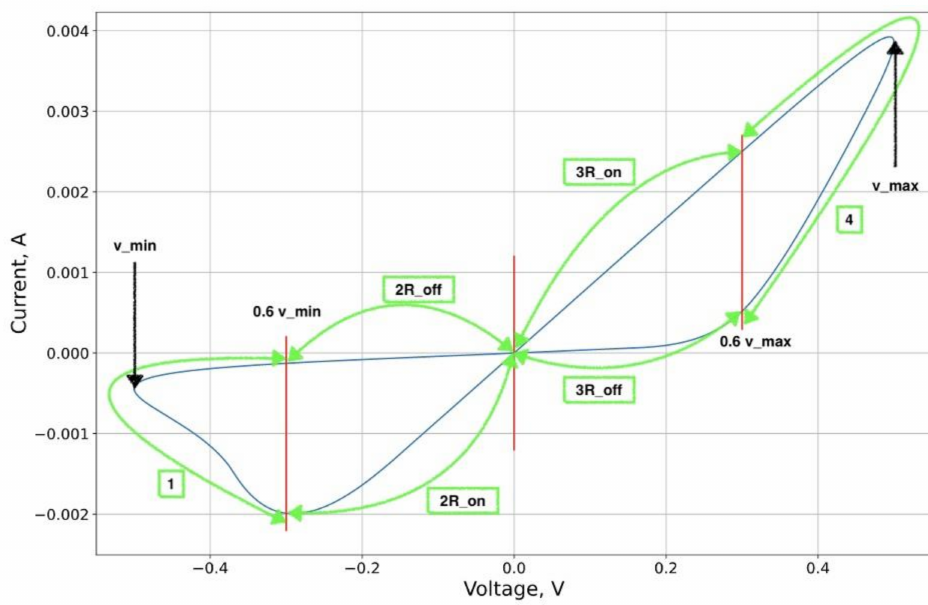
Figure 2. Example of volt–ampere characteristic (VAC) curve partition.